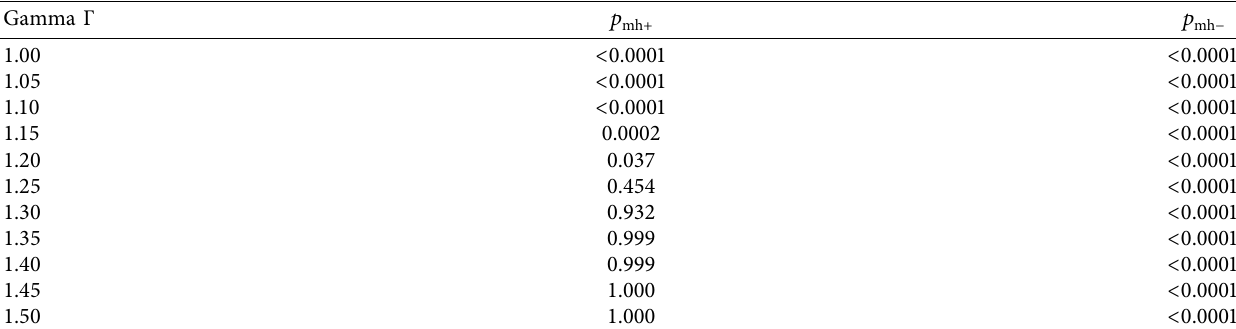
Table 5: Sensitivity to unobserved biases: Rosenbaum bounds for grandparental childcare treatment effects.